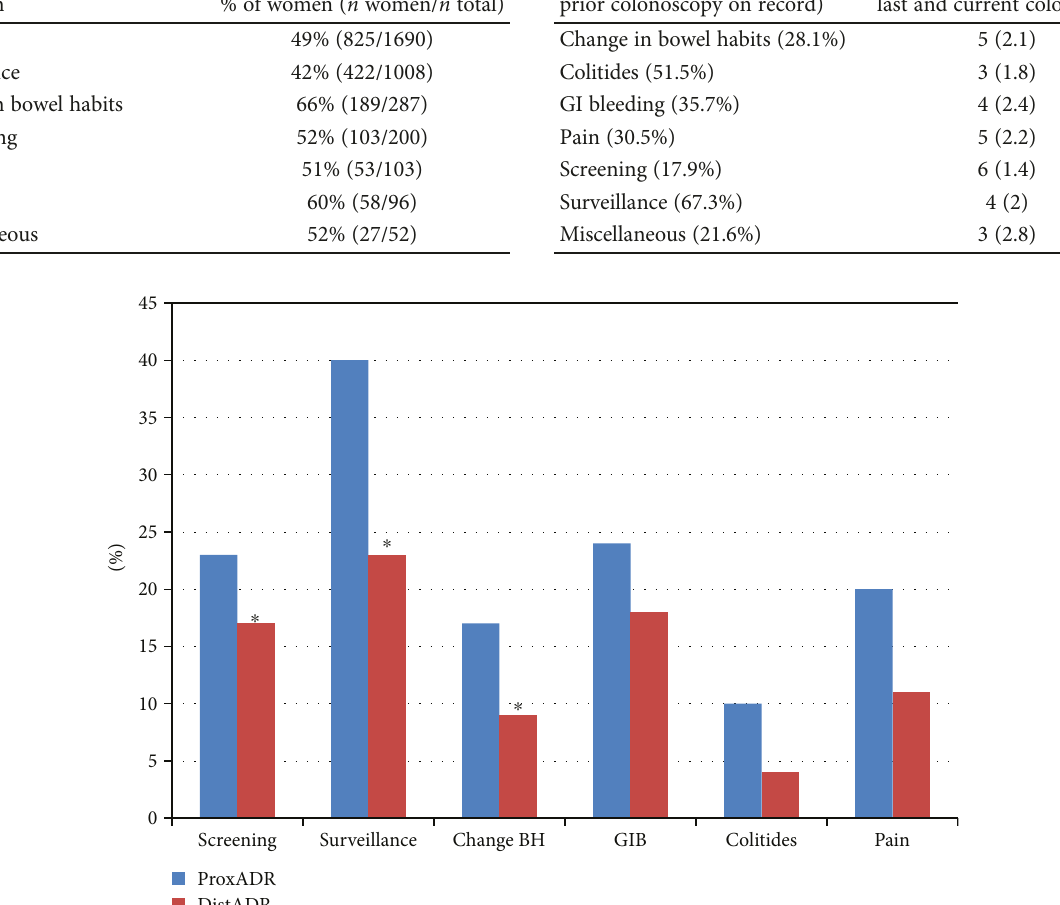
Figure 2: Proximal and distal ADR by colonoscopy indication. A bar graph is depicted comparing the adenoma detection rate from proximal colonic segments (proximal ADR) and distal colonic segments (distal ADR) for the various indications of screening, surveillance, change in bowel habit (BH), GI bleeding (GIB), colitides, and pain. The legend should state the following: ∗ signi fi cantly di ff ers between proximal and distal segments. Screening proximal ADR 20% versus distal ADR 11%, p < 0 001 ; surveillance proximal ADR 40% versus distal ADR 23%, p = 0 001 ; change in bowel habit (BH) proximal ADR 17% versus distal ADR 9%, p = 0 005 ; gastrointestinal bleeding (GIB) proximal ADR 24% versus distal ADR 18%, p = 0 154 ; colitides proximal ADR 10% versus distal ADR 4%, p = 0 109 ; pain proximal ADR 20% versus distal ADR 11%, p = 0 144